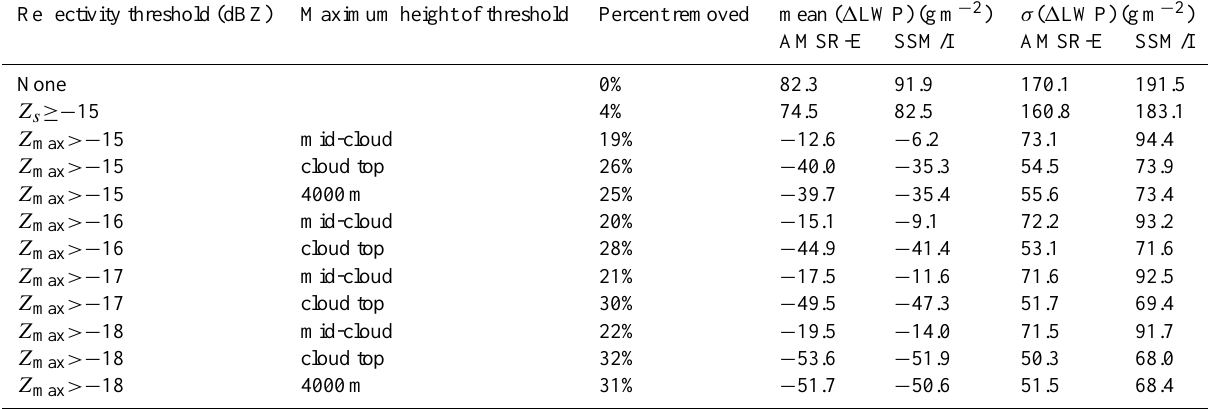
Table 2. Percentage of good-quality CloudSat LWP profiles removed, the mean differences in the LWPs between CloudSat and AMSR-E or SSM/I [mean( 1 LWP)], and the standard deviation in the differences between CloudSat and AMSR-E or SSM/I [ σ(1 LWP)] for various precipitation removal criteria in October-December 2008 for the region bounded by 12 ◦ S, 25 ◦ S, 70 ◦ W, and 90 ◦